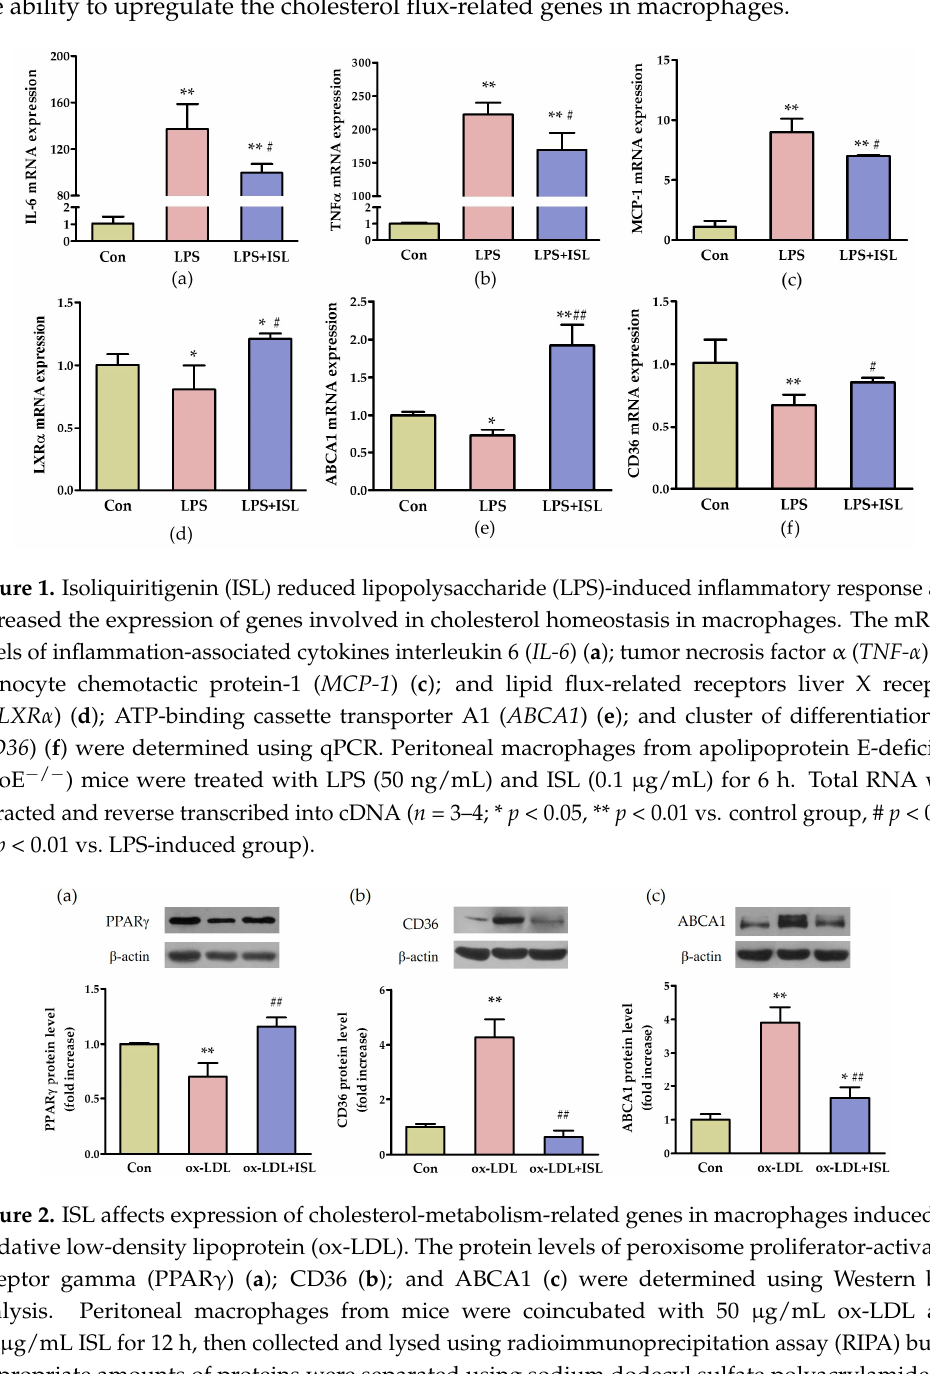
Figure 3. The effects of ISL on plasma lipids levels and antioxidative and anti-inflammatory status in apoE − / − mice fed a Western diet. Twenty-week old female apoE − / − mice were fed an AIN76A Western diet supplemented with 0.5% sodium carboxymethyl cellulose (CMC-Na) or ISL (20 mg/kg/d or 100 mg/kg/d) for 12-week, and then sacrificed. The plasma total cholesterol ( a ) and triglyceride ( b ) levels were measured at the indicated time as described in the Methods section ( n = 8–10; * p < 0.05, ** p < 0.01 vs. vehicle group at the same time point); ( c ) plasma lipoprotein pro fi les in apoE − / − mice with or without high-dose ISL (100 mg/kg/d) supplementation. Lipoproteins in pooled plasma were size-fractionated by fast protein liquid chromatography (FPLC), and the cholesterol contents within lipoprotein fractions (very low-density lipoprotein (VLDL), LDL, and high-density lipoprotein (HDL)) were measured; ( d ) the plasma superoxide dismutase (SOD) and paraoxonase-1 (PON1) activities of apoE − / − mice were measured at the endpoint using an enzymatic colorimetric assay ( n = 8–10; * p < 0.05, ** p < 0.01 vs. vehicle group); ( e ) plasma IL-6, TNF- α , and MCP-1 levels were determined using enzyme-linked immunosorbent assay (ELISA) ( n = 5–7; ** p < 0.01 vs. vehicle group).